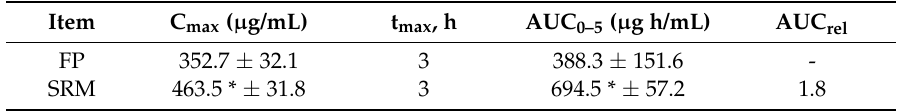
Figure 5. Plasma Fe 3+ concentration vs time plots following administration of 400 µL of a suspension (5 mg/kg of iron) of SRM and ferric pyrophosphate salt (FP, ferric pyrophosphate salt) (control) compared to Fe 3+ concentration in untreated animals (basal). Means ± SD of at least six values obtained with different animals. Table 1. Pharmacokinetic data in the blood following administration of 400 µL of a suspension (5 mg/kg of iron) of SRM and FP.